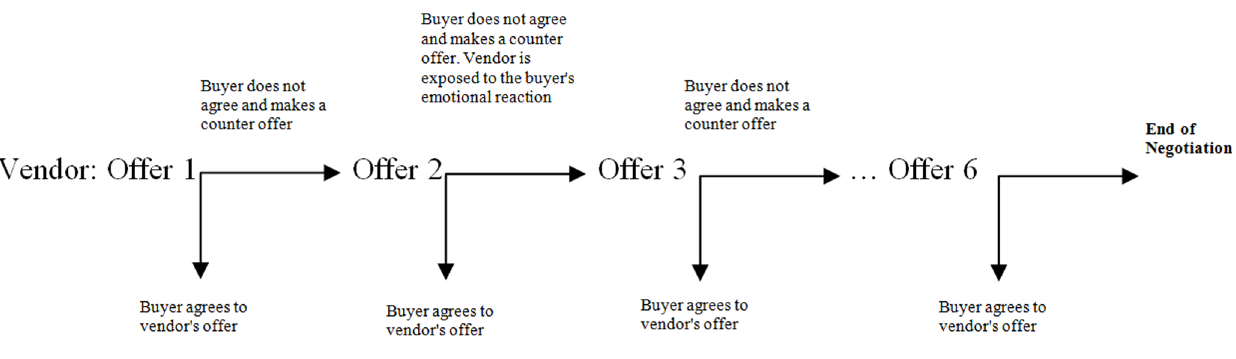
Figure 1. Graphic description of the negotiation